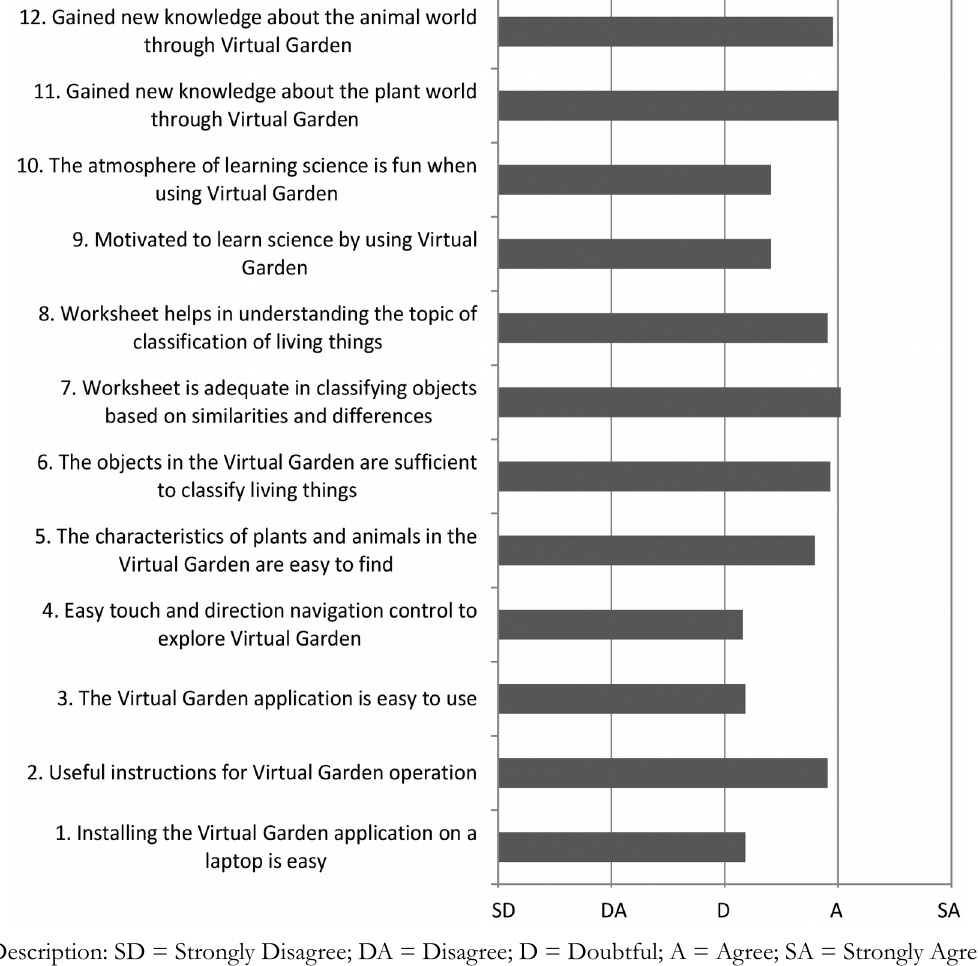
Figure 5. Student Responses to the Implementation of Virtual Garden